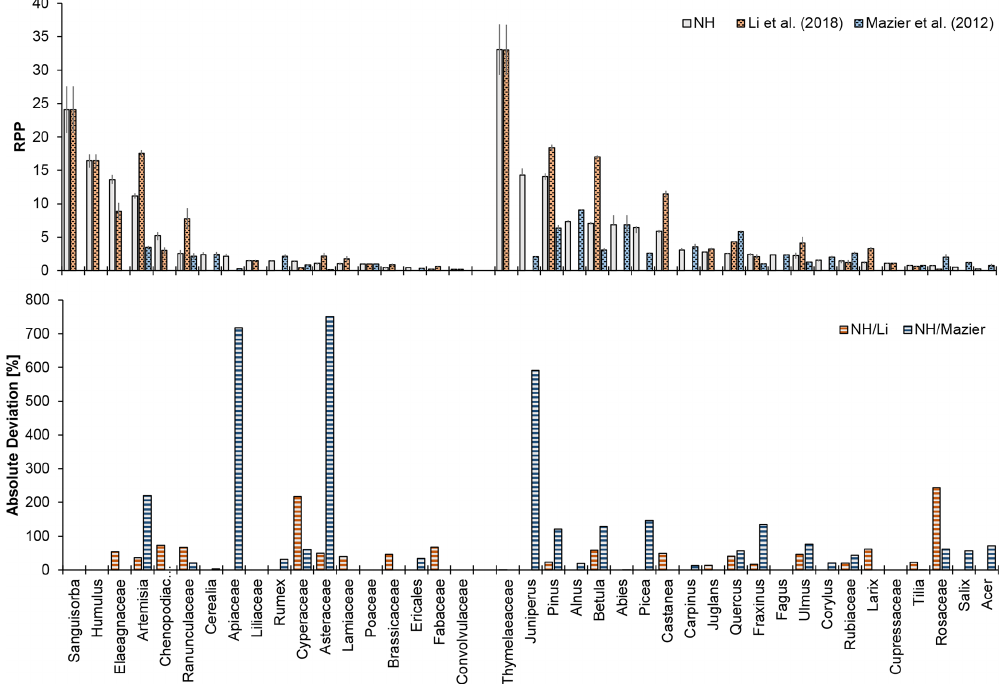
Figure 5. Relative pollen productivity (RPP) values for selected taxa from different studies (upper panel) and absolute percent- age deviation of the RPP northern hemispheric (NH) v2 dataset to previously published datasets (lower panel, calculated by ABS((RPP study − RPP NH ) / RPP study ) × 100). Previously published datasets are the Alt-1 dataset of Li et al. (2018) and PPE.st2 of Mazier et al.